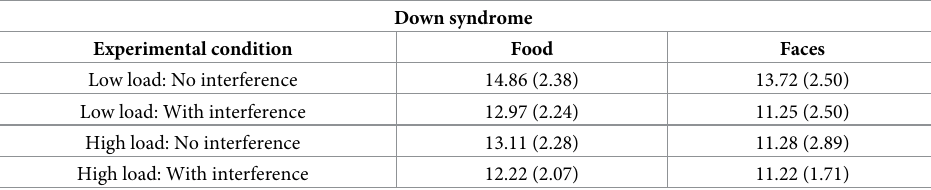
Table 5. Experimental task by material: Mean (standard